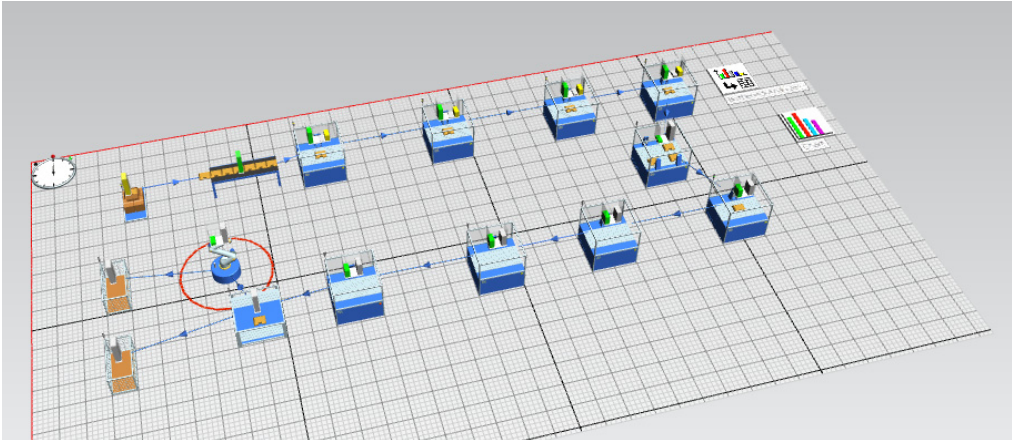
Figure 4. The sequence from the simulation in Tecnomatix of the designed system.